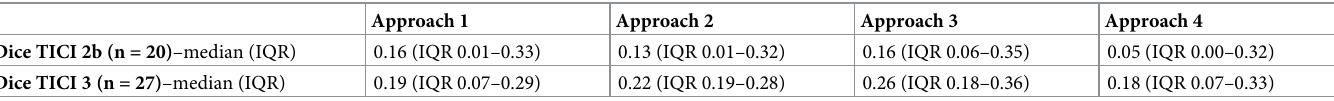
Table 3. Spatial agreement for patients with eTICI 2b vs. eTICI